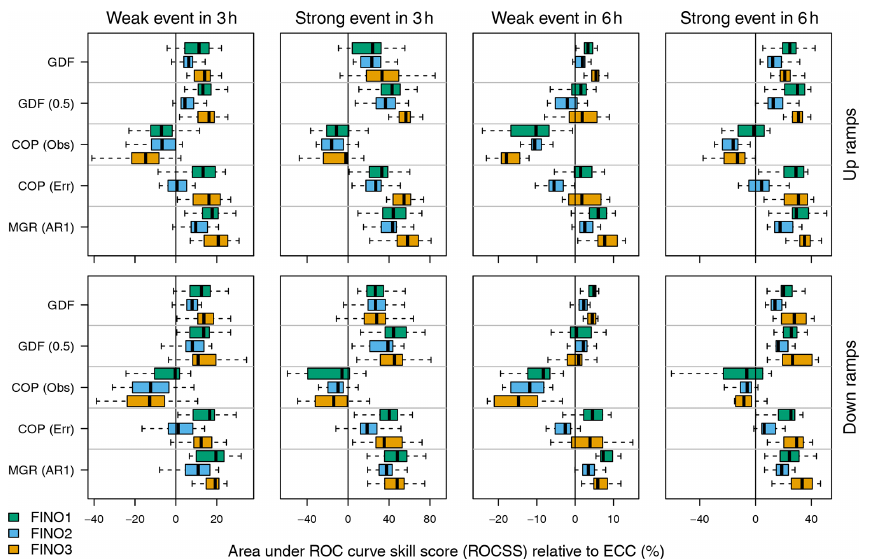
Figure 5. Area under the ROC curve skill score (ROCSS) relative to ECC at the three FINOs for weak and strong up ramps (top row panels) and down ramps (bottom row panels) within 3 and 6h time frames (leftmost and rightmost two columns, respectively). Individual boxplots are composed of scores computed for specific positions (i.e., starting points) of the time window. Three-hour time windows have 22 possible starting points ( + 24 to + 45h), and 6h time frames have 19 possible starting points ( + 24 to + 42h).